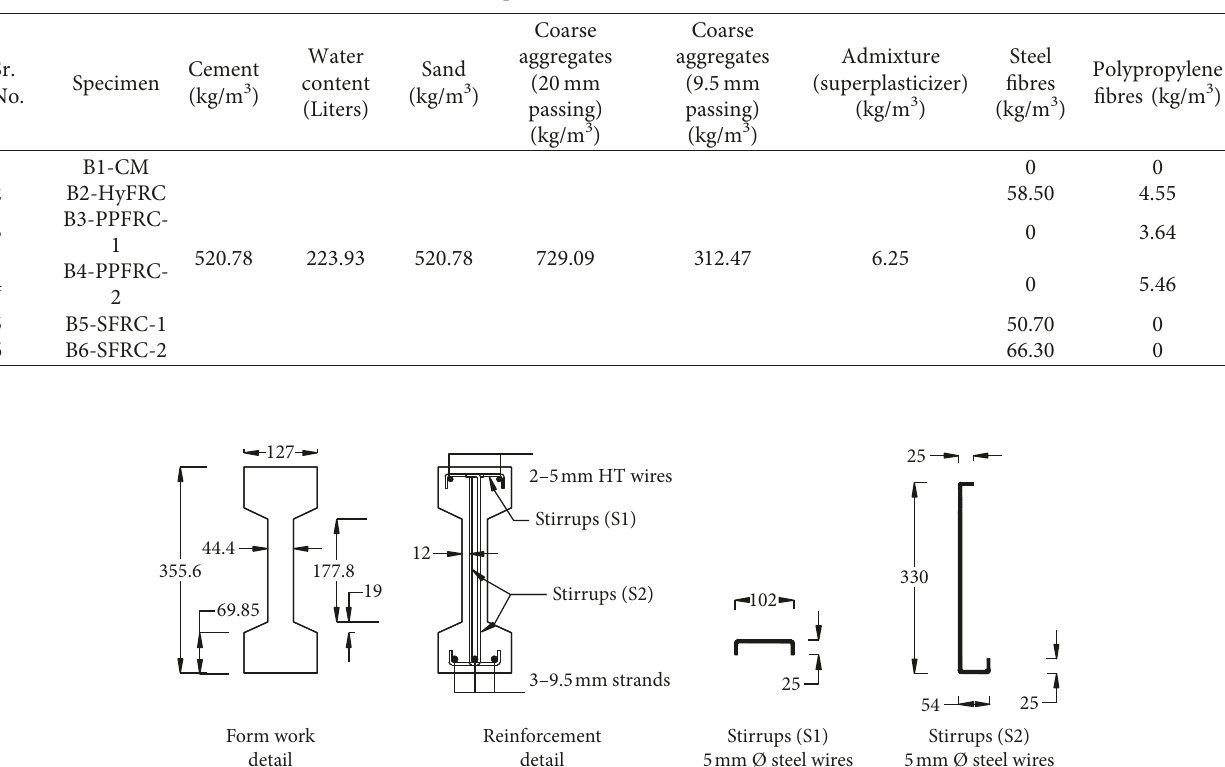
Table 1: Absolute quantities in a one-meter cube of concrete.